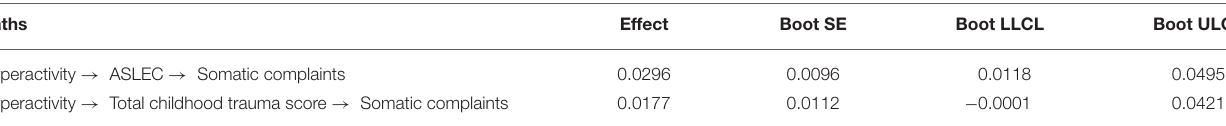
TABLE 4B | Test of the indirect path for the severity of childhood trauma and life events mediating the relationship between hyperactivity and somatic complaints. Paths